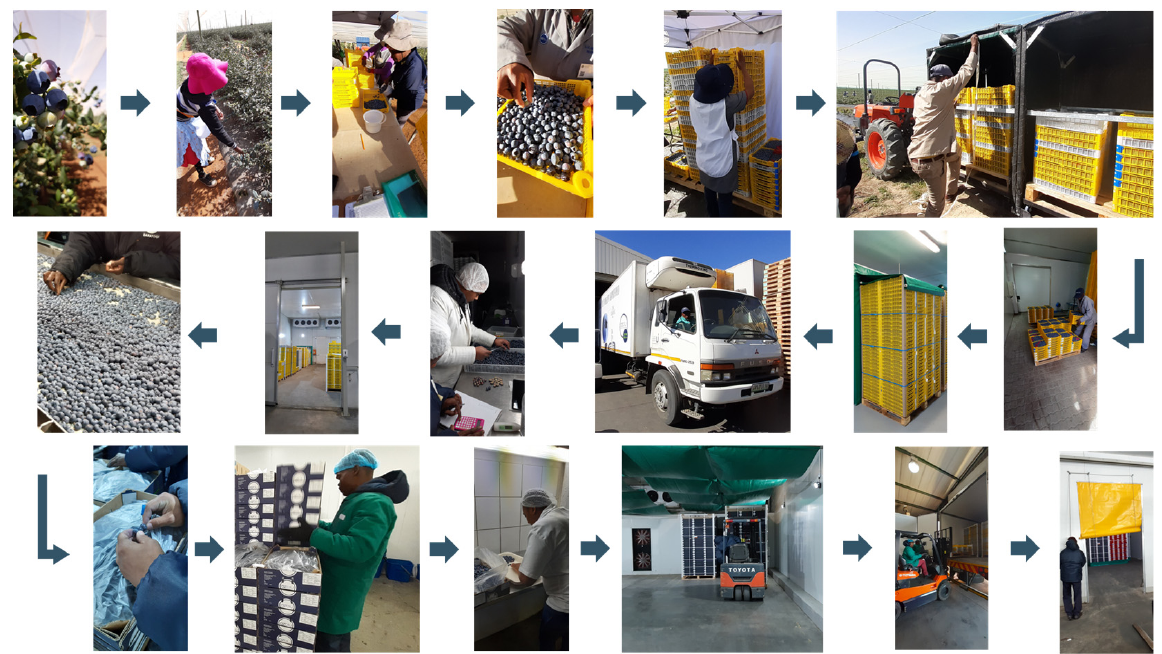
Figure 2. Blueberry Export Cold Supply Chain . Source: [13].